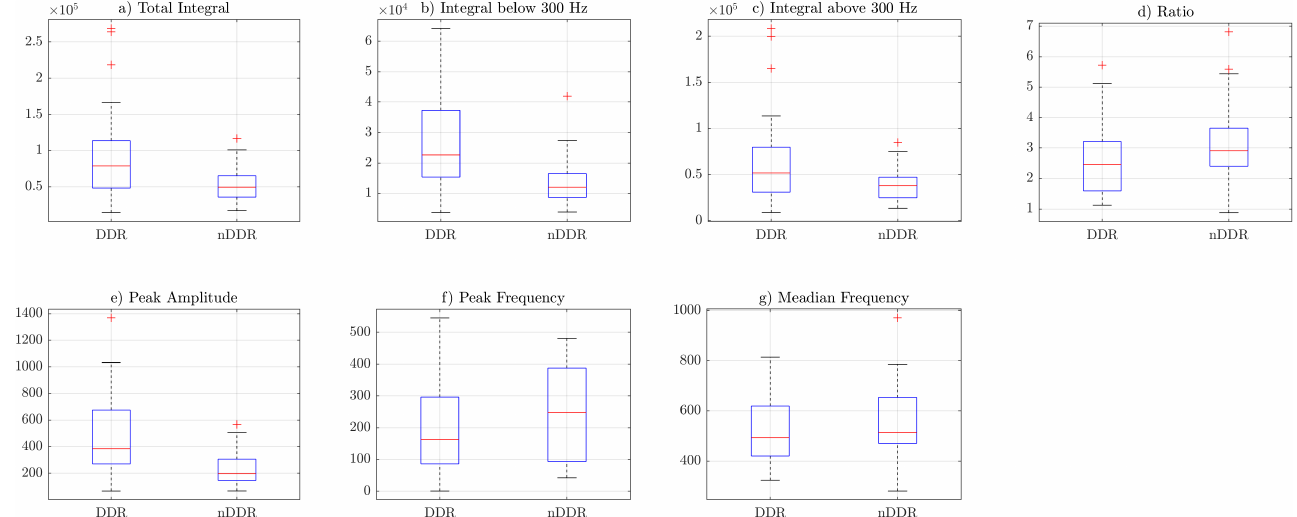
Figure A1. Box plots of raw features obtained for the first measurement: ( a ) TI feature, ( b ) IB3 feature,